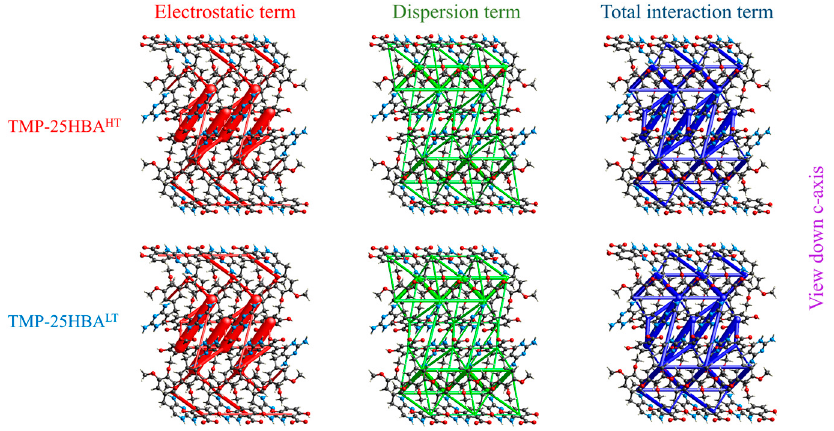
Figure 10. Energy frameworks corresponding to the different energy components and total interaction energy in TMP-25HBA LT and TMP-25HBA HT . The energy scaling factor is 88 and the energy threshold is 11 kJ/mol.